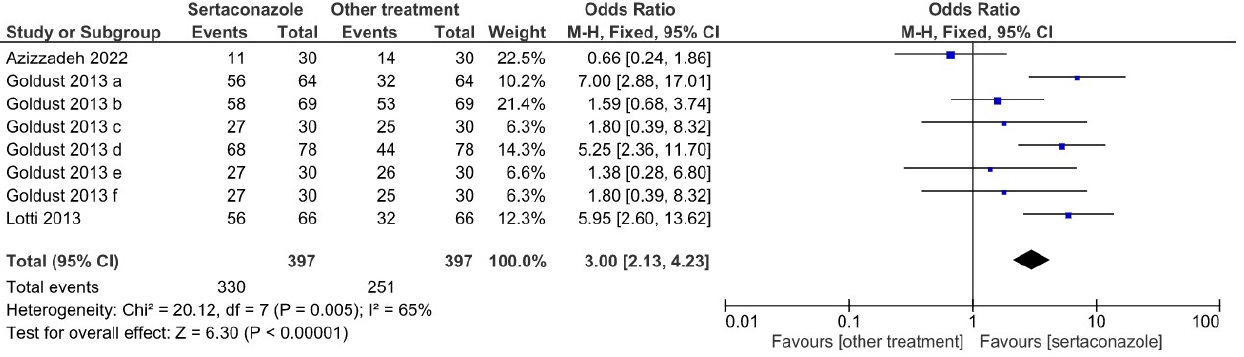
Figure 5. Forrest plot illustrating the effect of sertaconazole vs. other treatments in the eight selected studies for the “good” ranking in the self-assessment and patient satisfaction questionnaire at 28 days of treatment (OR with 95% confidence interval, heterogeneity, and overall effect).